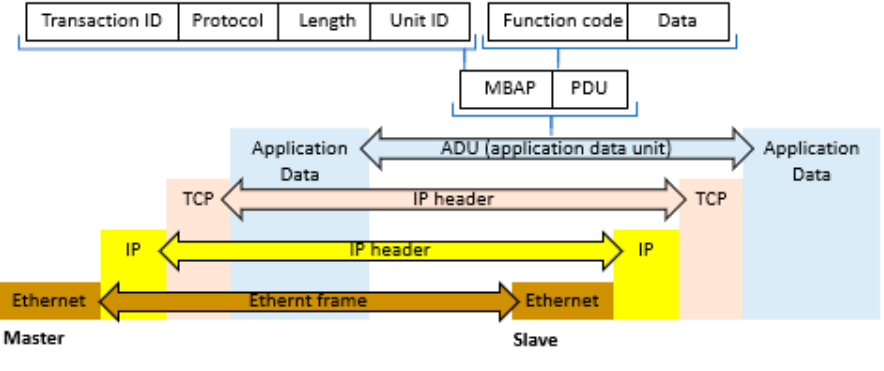
Figure 1. Modbus TCP/IP ADU